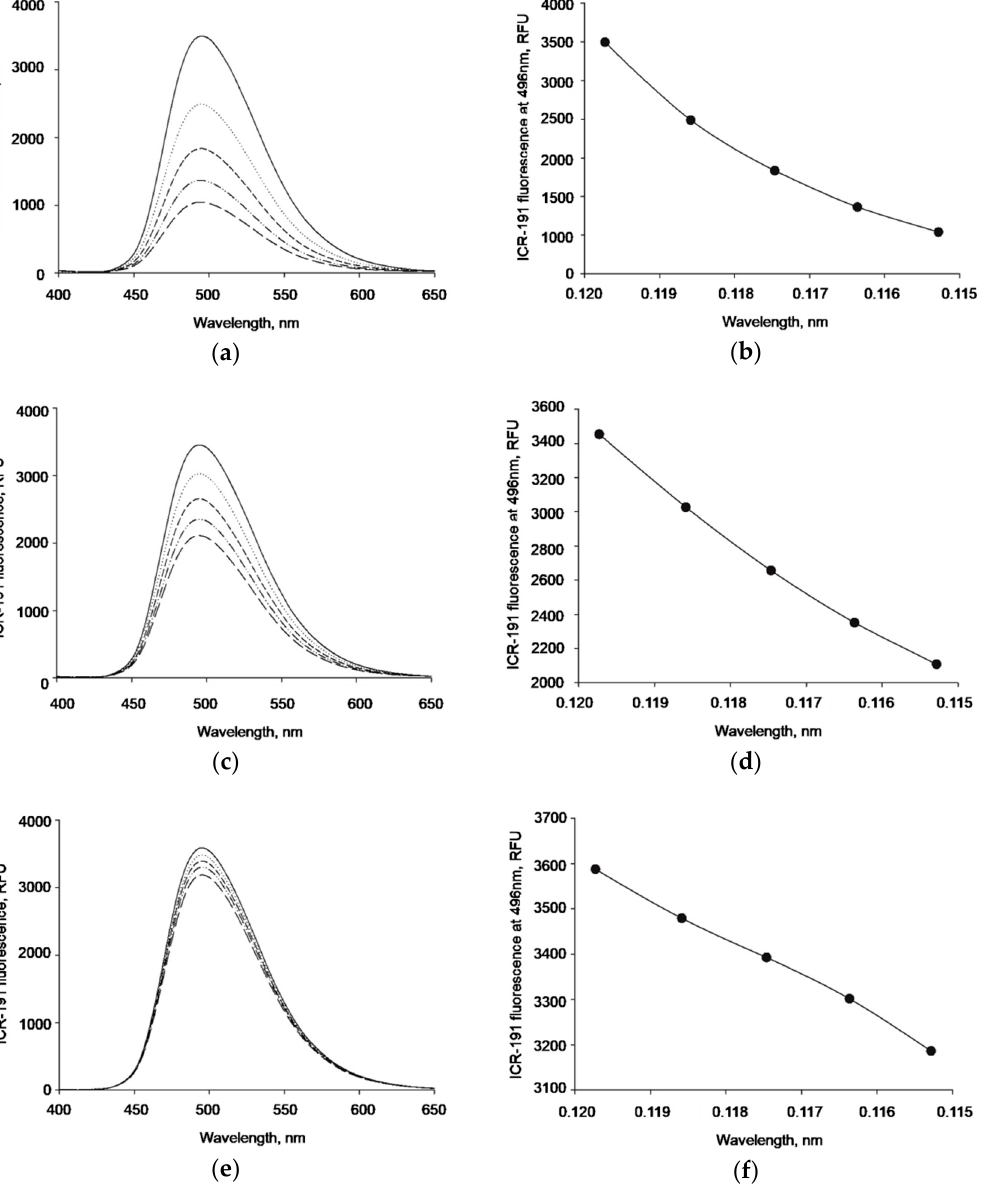
Figure 5. ICR-191 fluorescence changes caused by AgNPs. ( a ) Fluorescence emission spectrum of ICR-191 (primary concentration: 119.73 µ M) titrated with increasing amount of naked AgNPs (concentration range: 25.30–98.38 µ g / mL); ( b ) data registered for naked AgNPs shown as a relationship between the fluorescence intensity at the maximum point (496 nm) and the ICR-191 concentration; ( c ) fluorescence emission spectrum of ICR-191 (primary concentration: 119.73 µ M) titrated with increasing amount of AgNP-TBA (concentration range: 5.97–23.20 µ g / mL); ( d ) data registered for AgNP-TBA shown as a relationship between the fluorescence intensity at the maximum point (496 nm) and the ICR-191 concentration; ( e ) fluorescence emission spectrum of ICR-191 (primary concentration: 119.73 µ M) titrated with increasing amount of AgNP-MUA (concentration range: 0.63–2.43 µ g / mL); ( f ) data registered for AgNP-MUA shown as a relationship between the fluorescence intensity at the maximum point (496 nm) and the ICR-191 concentration. RFU—relative fluorescence